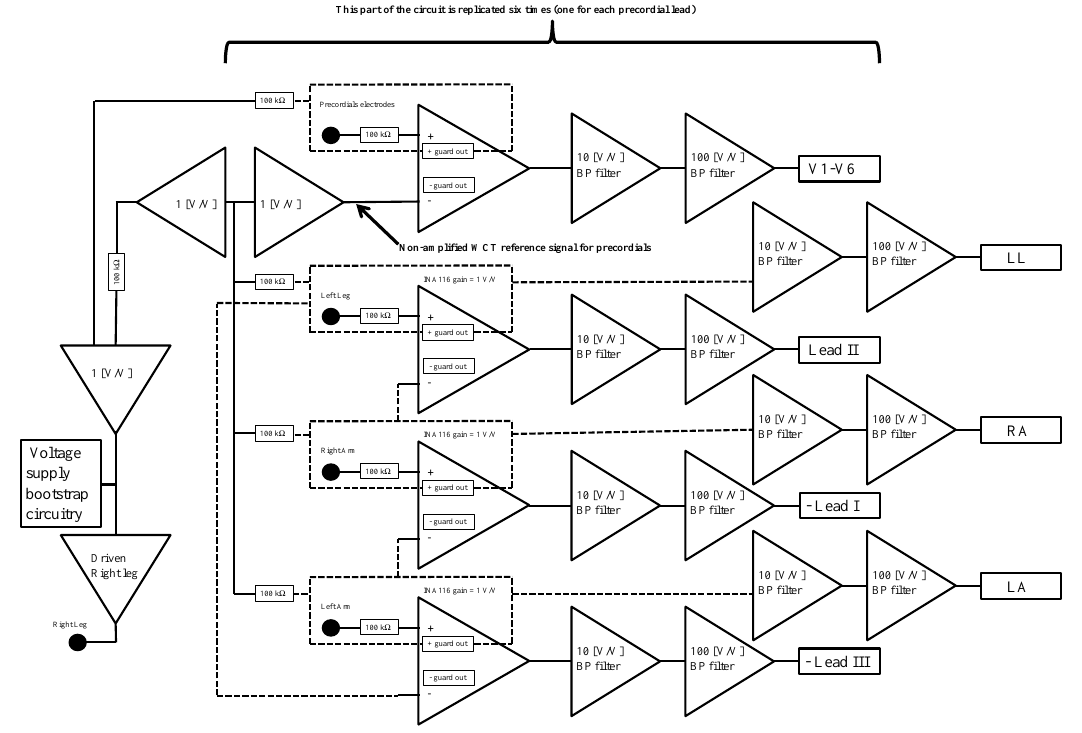
Figure 2. Simplified schematic limited to limbs’ connections and one of the precordials.